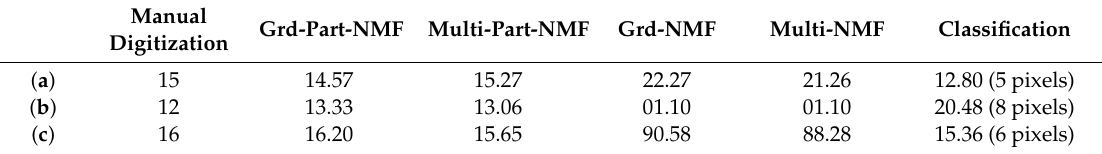
Table 3. Photovoltaic panel areas (m 2 ) for: ( a ) sub-image 1, ( b ) sub-image 2, and ( c ) sub-image